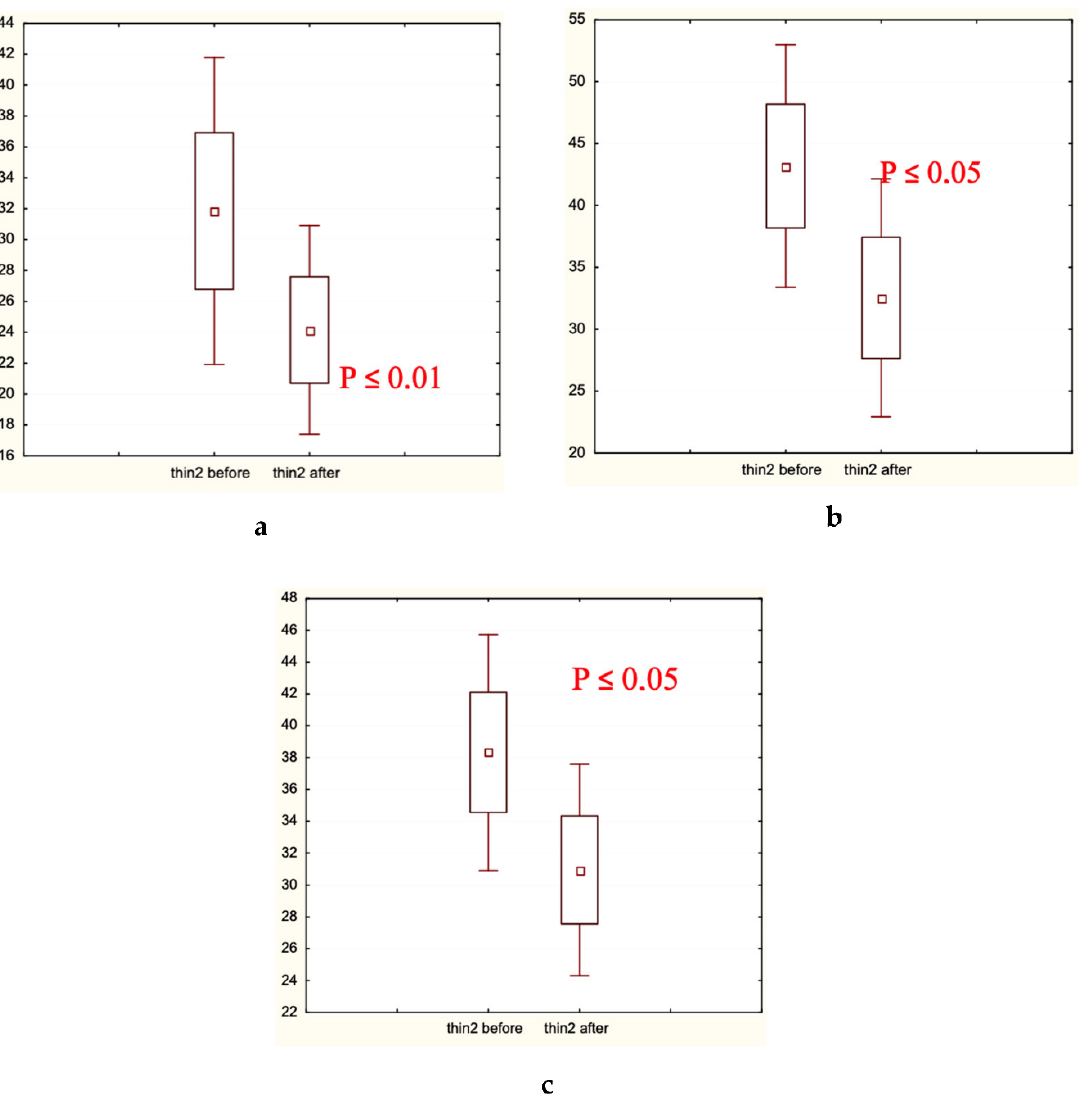
Figure 9. Thin hair presence (%) before and after the trial: ( a ) Experimental Group 1; ( b ) Placebo Control Group 2; ( c ) Caffeine Control Group 3. Small boxes — median values; large boxes — median values ± standard error of median (SEM); whiskers — median values ± 1.96 SEM. p < 0.05, p < 0.01.